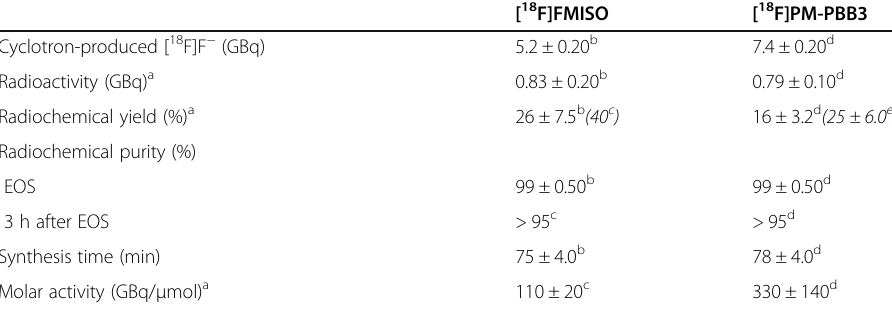
Table 1 Radiosynthesis results of [ 18 F]FMISO and [ 18 F]PM-PBB3 by 18 F-fluoroalkylation using precursor 6 and [ 18 F]5 Cyclotron-produced [ 18 F]F − (GBq) 5.2 ± 0.20 b 7.4 ± 0.20 d